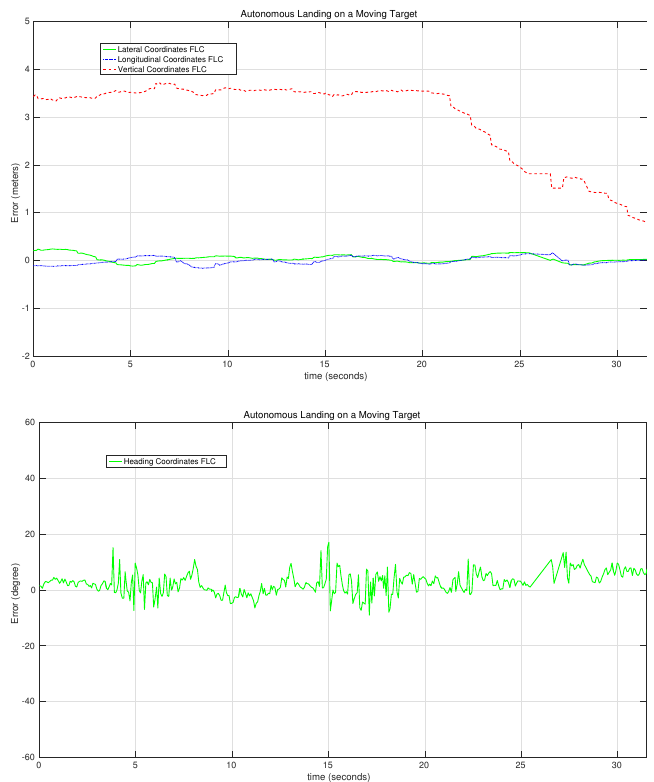
Figure 21. Evolution of the error of the lateral, longitudinal, vertical and heading controllers on the third autonomous landing on a moving target